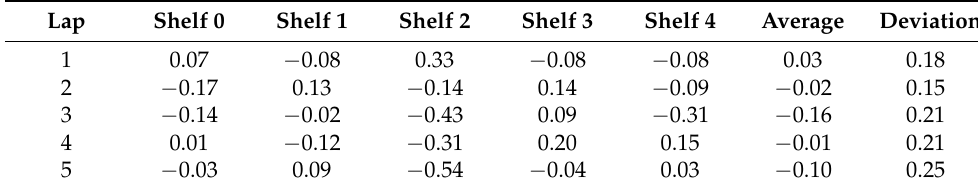
Table 2. Position error in Y direction (unit: cm).